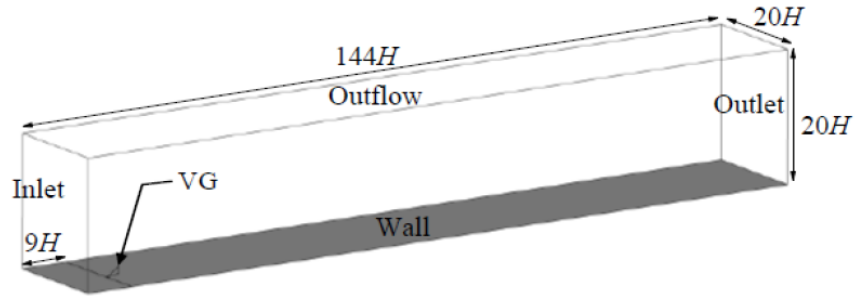
Figure 2. Computational domain and boundary conditions.